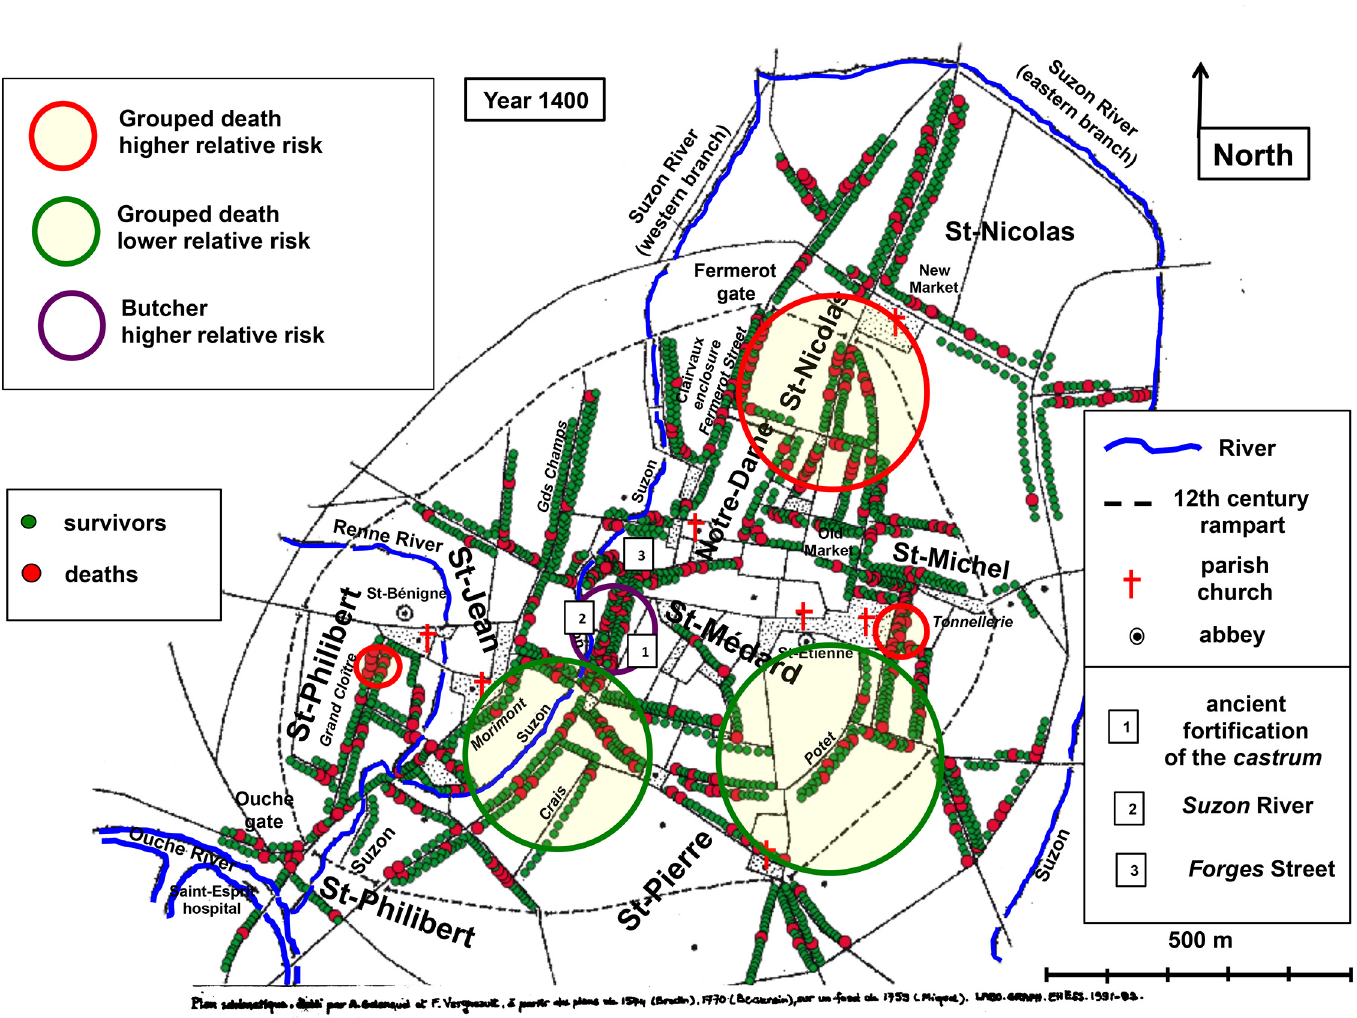
Fig 2. Cartography of death in 1400. Georeferenced map of medieval Dijon. Rivers as blue lines. Parish churches, abbeys and a number of prominent places are indicated. The streets mentioned in the text are italicized. The 12th century rampart is shown by dotted lines. Each point corresponds to a surviving head of household (green points) or to a registered death (larger red points). Yellow areas circled in red: clusters with a higher relative risk of grouped death. Yellow areas circled in green: clusters with a lower or null relative risk of grouped death. Empty area circled in purple: cluster of higher density of butchers in the Bourg district. The Bourg district stood between the ancient fortification of the castrum (1) and the Suzon River (2) and its northern end was contiguous to Forges Street (3). Historical evidence of the location of the statistically significant clusters is presented in S9 Text